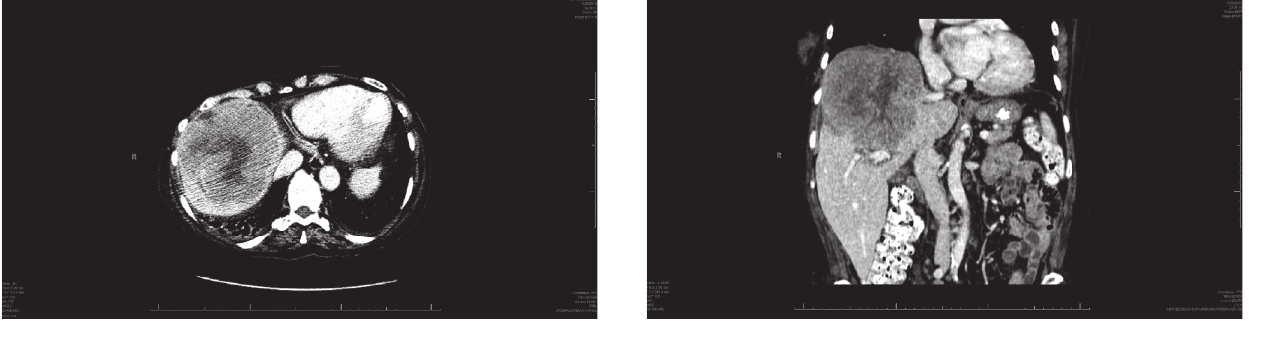
Figure 1: Axial view of primary hepatic lymphoma. Figure 2: Coronal view of primary hepatic